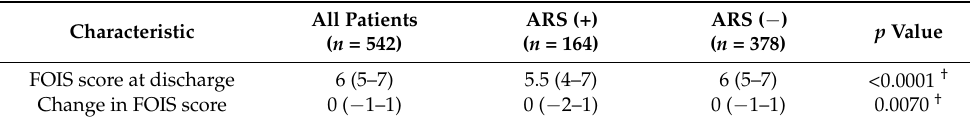
Table 2. Univariate analysis of outcomes between ARS (+) and ARS (–) groups.